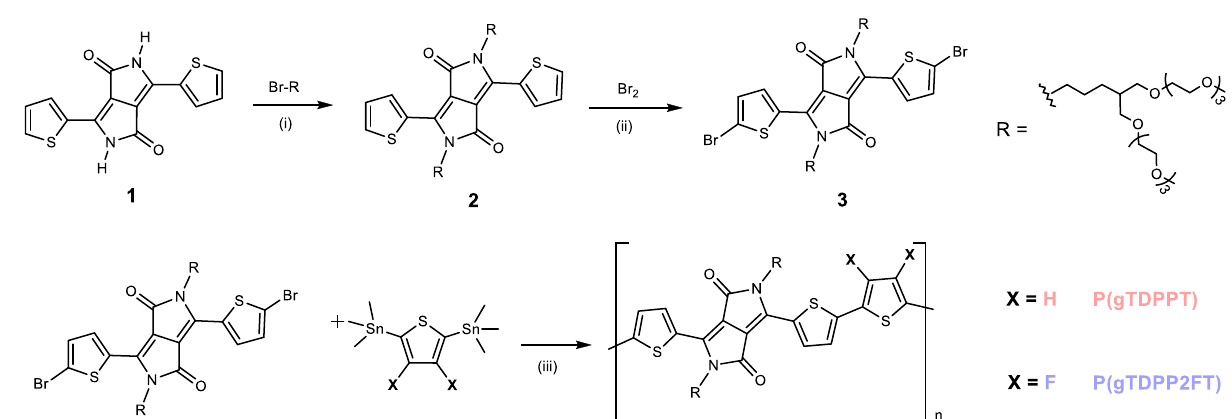
Fig.1|Syntheticroutestothepolymers,P(gTDPPT)andP(gTDPP2FT). Reagentsandconditions:(i)K 2 CO 3 ,DMF,110°C,12h;(ii)Br 2 ,DCM,0°C,2h;(iii)Pd(PPh 3 ) 4 ,CuI, Toluene/NMP (v/v=1/1), 110°C,